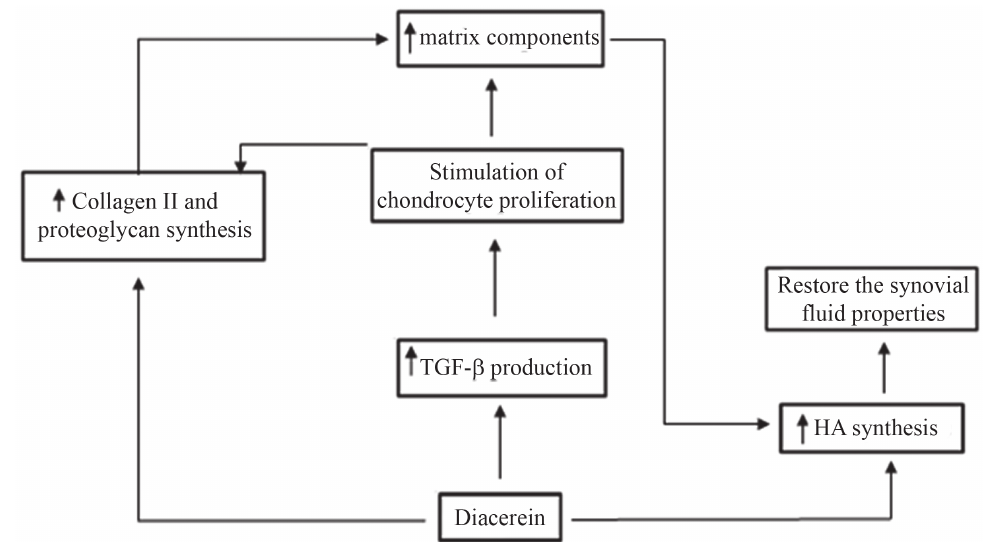
FIGURE 2- Anabolic effect of DCN (Medhi et al .,